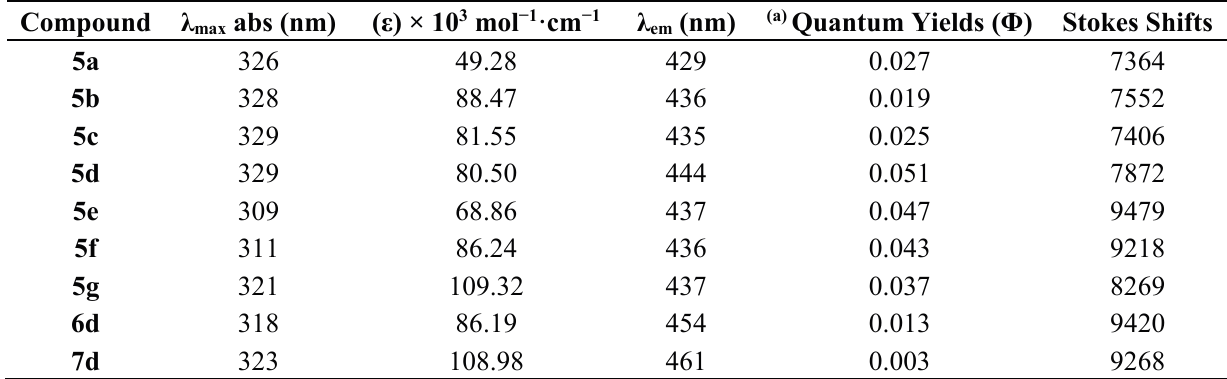
Figure 2. Emission spectra of 5a – g , 6d and 7d in CH 2 Cl 2 (r.t.) at 7.5 × 10 − 6 mol/L ( λ ex = 355 nm). Table 1. The absorption and emission data for compounds 5a – g , 6d and 7d .